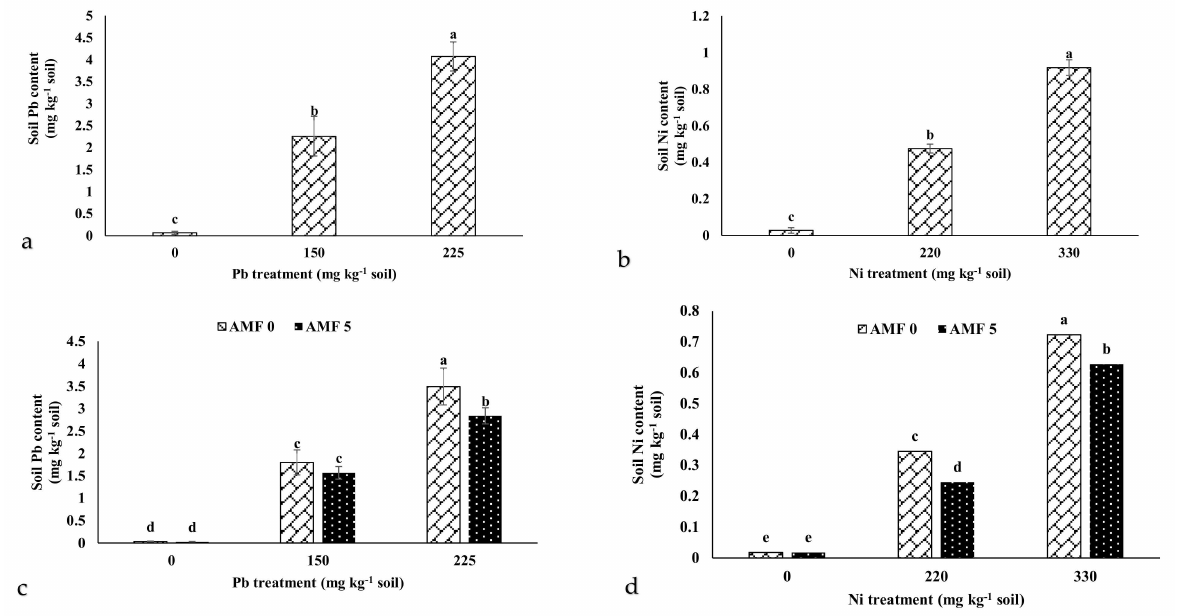
Figure 6. The effect of soil-based use of Pb and Ni and arbuscular mycorrhiza fungi (AMF) inoculation on the soil Pb content before planting ( a ) and after lavender plant harvest ( c ) as well as Ni content before planting ( b ) and after harvest ( d ) of lavender plants. Different letters indicate significant differences according to the LSD test at p <